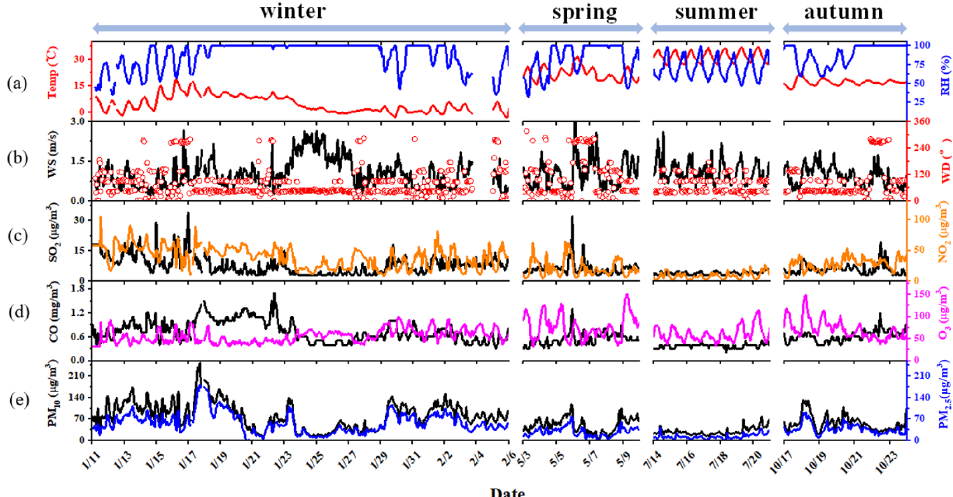
Figure 1. Time series of ( a ) relative humidity (RH) and temperature; ( b ) wind direction and wind speed; ( c , d ) mass concentrations of CO, NO 2 , SO 2 , and O 3 (hourly data); ( e ) PM 10 and PM 2.5 mass concentration during the sampling periods of spring, summer, autumn, and winter. The average concentration of PM 2.5 was the highest in winter (69 ± 25.6 μg/m 3 ), followed by autumn (37.9 ± 8.9 μg/m 3 ) and spring (27.9 ± 10.4 μg/m 3 ), and the lowest value was observed in summer (12.6 ± 5.5 μg/m 3 ). The seasonal variation of SO 2 and NO 2 were the same with PM 2.5 , indicating that the atmosphere was more polluted in winter compared with other seasons, whereas the average O 3 concentration was the highest during the sampling periods in spring and then in autumn, followed by summer, as summarized in Table S1 in the Supplementary Materials. The factors influencing O 3 formation are yet to be revealed in future studies. 3.2. Seasonal Variation of PM 2.5 Composition The major composition of PM 2.5 was NO 3 − , NH 4 + , SO 42 − , OM, WSOM, and EC in each season, which took up 50–70% of PM 2.5 . Each component had the highest concentration in winter, followed by autumn, spring, and summer, which is consistent with the seasonal variation of PM 2.5 , as illustrated in Figure 2a. The relative contribution of each component was different (Figure 2b). The relative contribution of the organic species was almost equal to the inorganic species in spring (~29%) and increased in summer. However, the percentage of organic species in PM 2.5 decreased in autumn and winter, which was the same as in previous studies [48,49]. In inorganic species, the contribution of NO 3 − , NH 4 + , and SO 42 − decreased in summer compared to spring and increased in autumn and winter. The proportions of NO 3 − and NH 4 + increased most significantly in autumn and winter, indicating that the increase in PM 2.5 was likely due to the formation of NO 3 − and NH 4 + in these seasons. The higher levels of NO 3 − and NH 4 + in winter may be related to the higher stability of NH 4 NO 3 at low temperatures.